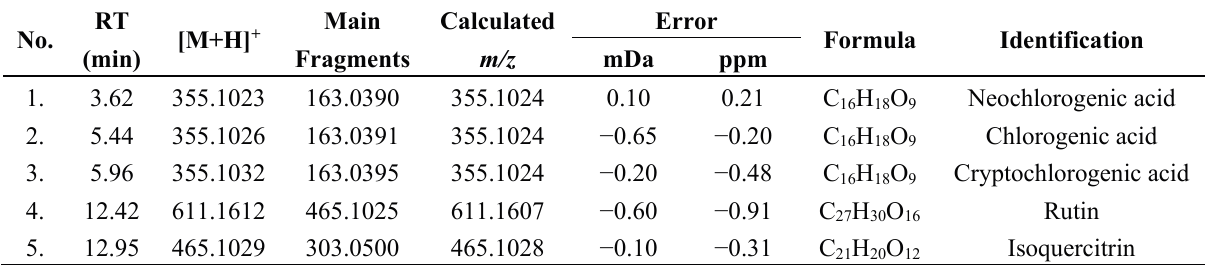
Table 5. MS data of the five compounds from H. sabdariffa by